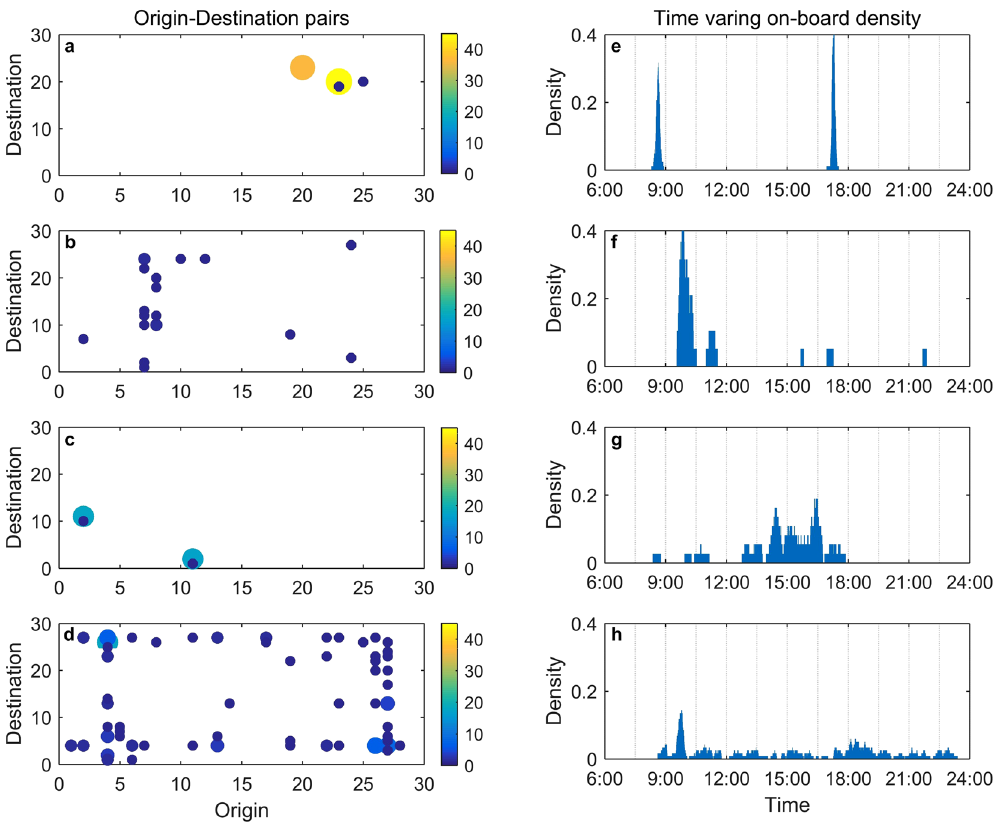
Figure 2. Individual spatial and temporal regularities. Each row corresponds to the individual in the same row in Fig. 1. ( a–d ) Each scattered dot represents an observed origin-destination pair with its area and colour showing the count of observations. Dots with larger areas and warmer colours represent a higher degree of spatial displacement regularity. ( e – h ) The empirical on-board density at each time is calculated by the on-board count at that time over the total number of observations. Narrower support with fewer sharp peaks suggests a higher degree of temporal recurrence